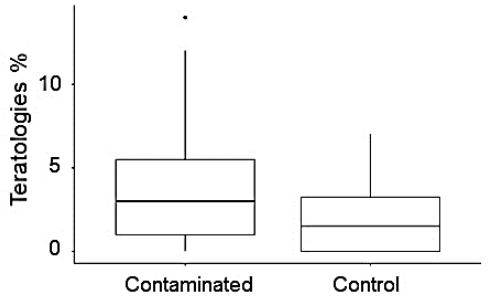
Figure 4. Box-plot showing the distribution of teratology (percentages) between control stations and stations receiving treated mine effluents or nonpoint source contamination from mining activities.